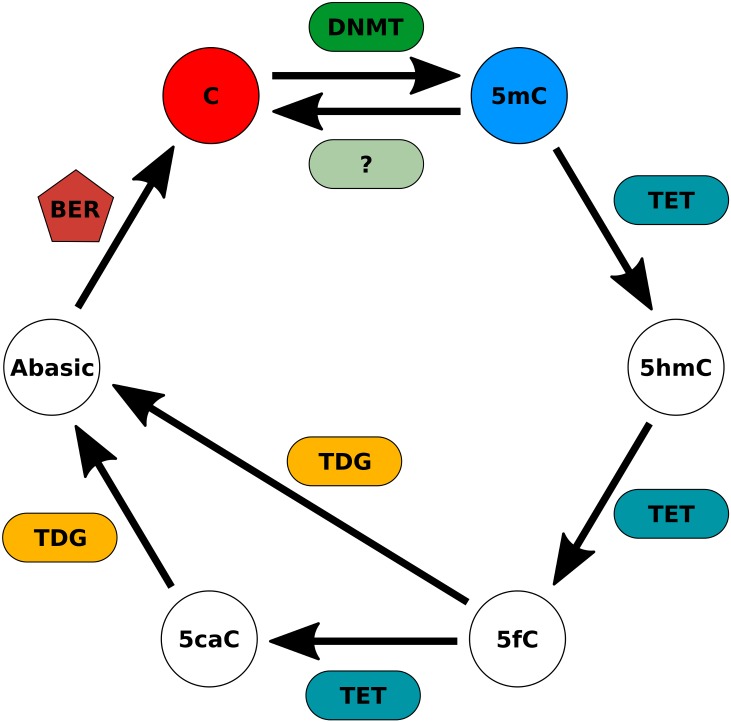
Enzymes that can possibly play the role of the rates α, β, δ and ζ used in the model.The question mark indicates the possible existence of an enzyme that directly converts 5-methylcytosine into cytosine. C—Cytosine; 5mC—5-Methylcytosine; 5hmC—5-Hydroxymethylcytosine; 5fC—5-Formylcytosine; 5caC—5-Carboxylcytosine; Abasic—Abasic site; DNMT—DNA methyltransferase; TET—Ten-eleven translocation enzymes; TDG—Thymine DNA glycosylase; BER—Base excision repair.